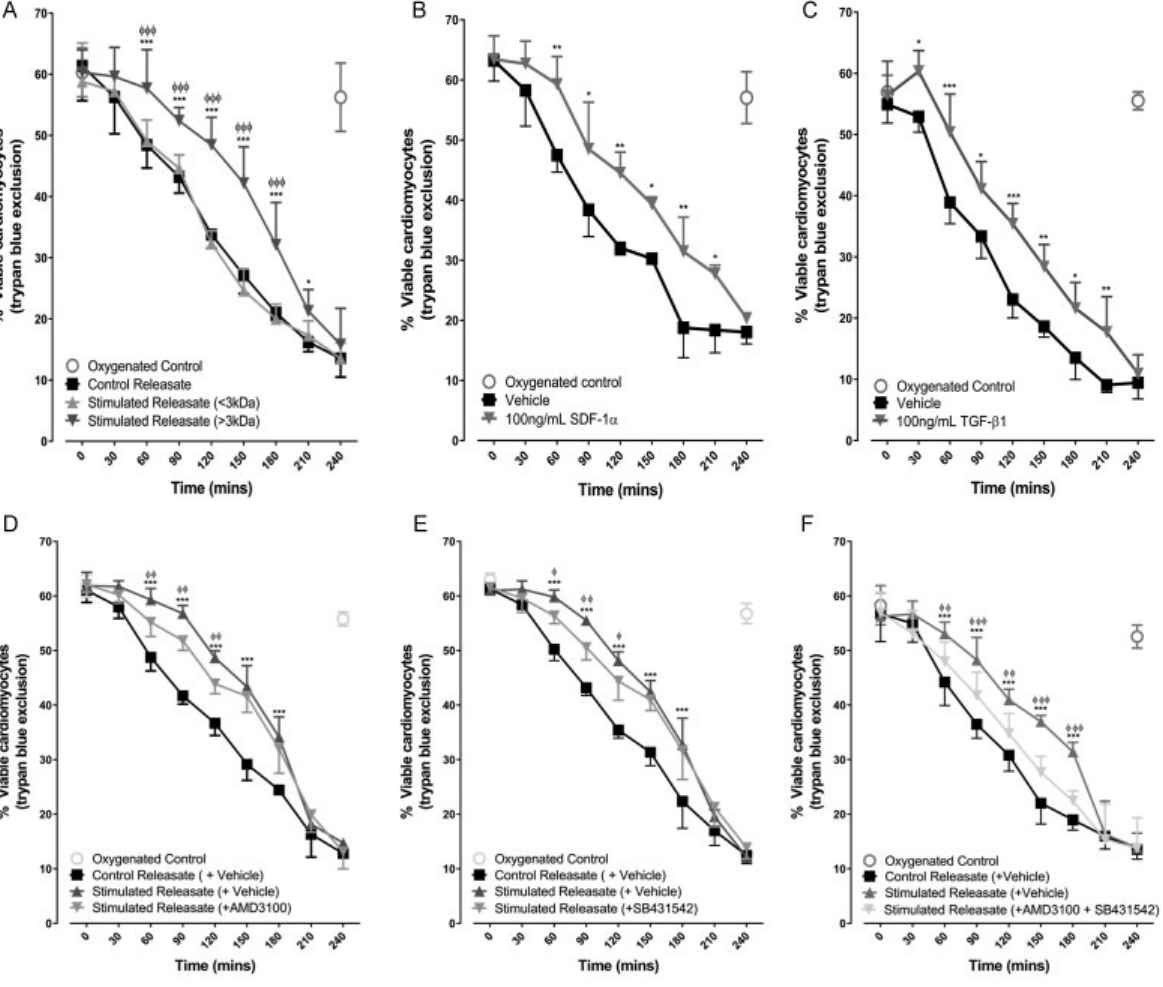
Fig. 2 Role for platelet α -granule proteins, SDF-1 α and TGF- β 1, in mediating the protective effects of platelet secreted factors. ( A – F ) Cardiomyocytes were preconditioned with releasates from vehicle-treated (control) WT platelets: ( A ) fi ltered, < 3 kDa and retained, > 3 kDa releasates from CRP-treated (stimulated) WT platelets; ( B ) recombinant SDF-1 α (100 ng/mL); ( C ) recombinant TGF- β 1 (100 ng/mL) and ( D – F ) un fi ltered releasate from CRP-treated (stimulated) WT platelets, then monitored for cardiomyocyte viability for up to 240 minutes of ischemic injury,withnonischemic (oxygenated control) samples monitoredat 0- and240-minutetime points. ( D – F ) Cardiomyocyteswere pretreatedwith vehicle control (0.1% DMSO) or inhibitors: ( D ) 0.5 µM AMD3100 (CXCR4 antagonist); ( E ) 1 µM SB431542 (TGFBR1 antagonist), and ( F ) 0.5 µM AMD3100 and 1 µM SB431542 for 30 minutes prior to releasate preconditioning. Data are mean (cid:4) SD ( n ¼ 4 for ( A ) and ( F ), n ¼ 3 for B – E ); (cid:5) p < 0.05, (cid:5)(cid:5) p < 0.01, (cid:5)(cid:5)(cid:5) p < 0.001 versus control releasate ( A, D – F )/vehicle ( B,C ) and Φ p < 0.05, ΦΦ p < 0.01, ΦΦΦ p < 0.001 versus stimulated releasate ( < 3 kDa ( A )/ þ AMD3100 ( D )/ þ SB431542 ( E )/AMD3100 þ SB431542 ( F